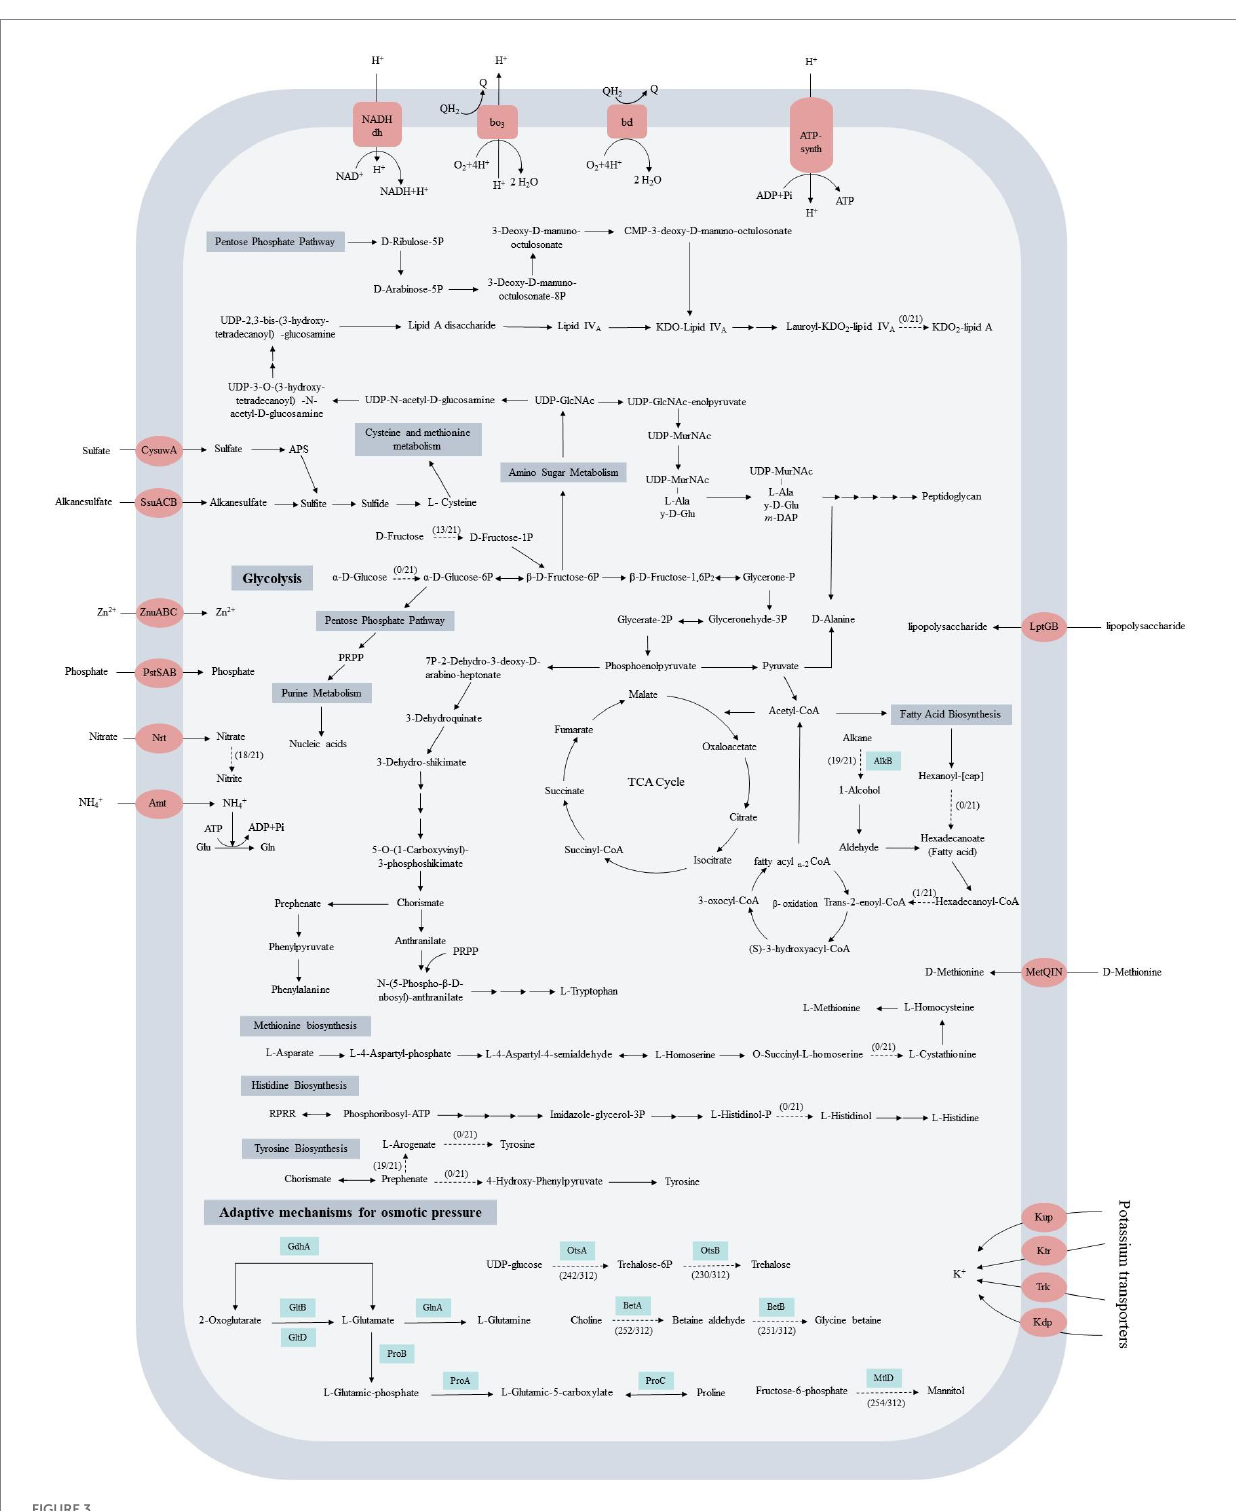
FIGURE 3 Prediction of the central metabolic potential of 21 complete genomes of Acinetobacter strains and the possible hyperosmolar mechanisms of adaptation of 312 strains. Potential genes related to carbon, nitrogen, and energy metabolism in the central metabolic pathways were analyzed, and the genes predicted to be involved in these metabolic pathways are listed in Supplementary Table S2. Solid lines indicate pathways common to all bacteria, and dashed lines indicate partial